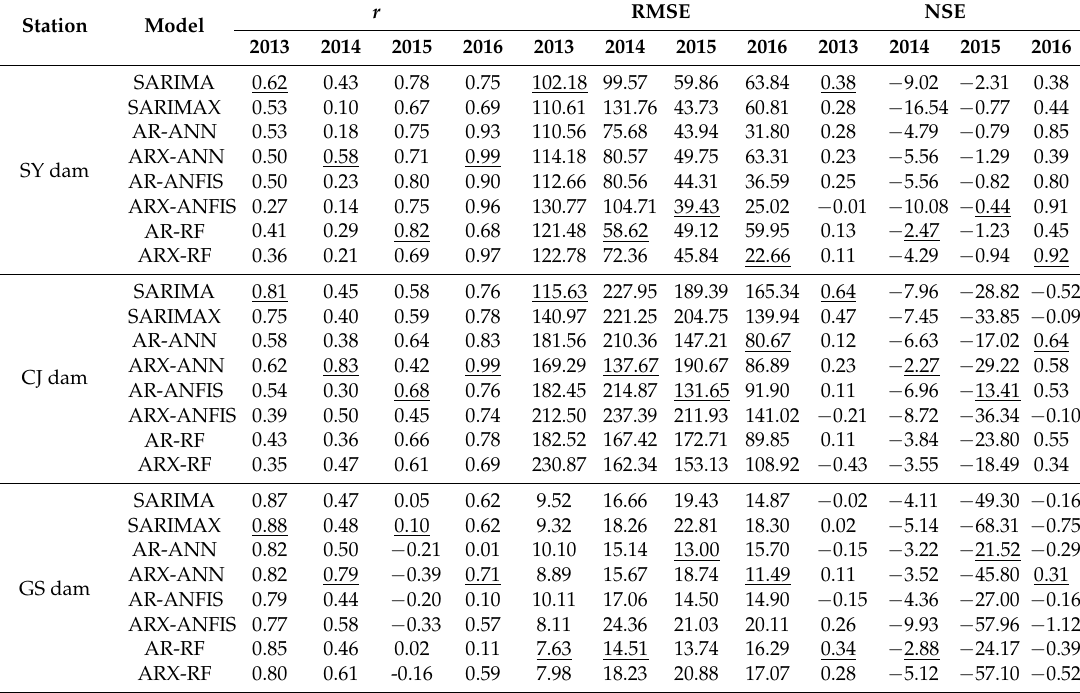
Table 10. Model performance of the SARIMA, SARIMAX, AR-ANN, ARX-ANN, AR-ANFIS, ARX-ANFIS, AR-RF, and ARX-RF models by year during test period for the three dams.